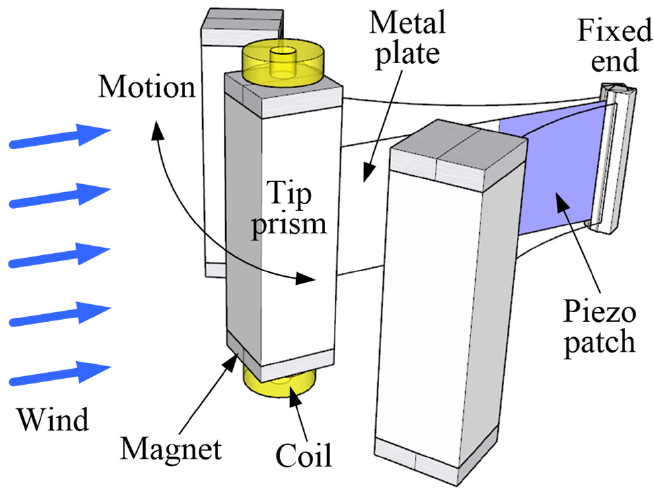
Figure 1. Schematic of a typical galloping energy